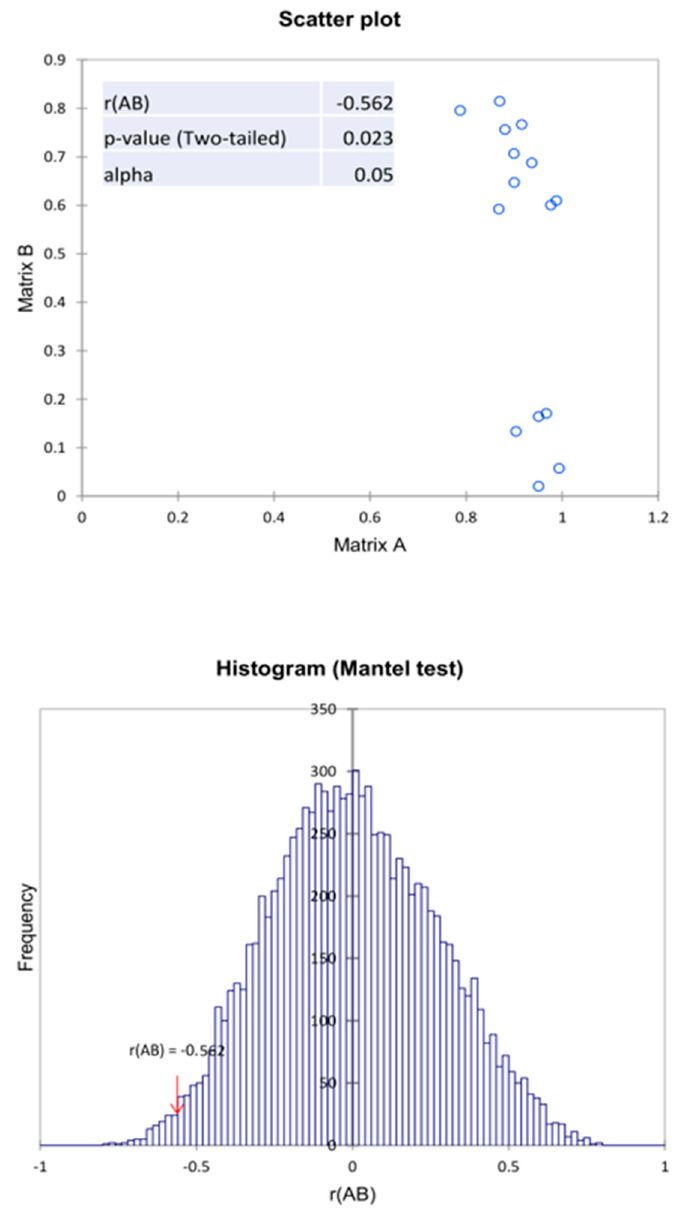
Figure 8. Mantel test of the correlation matrix of the bacteria with the biochemical activity in relation to the variants examined in the experiment.